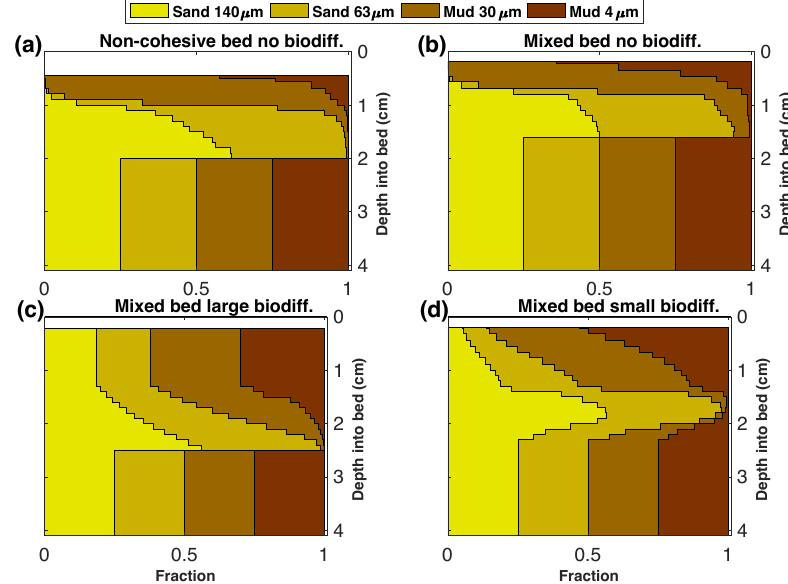
Figure 7. Comparison of final bed stratigraphy for resuspension and settling simulations showing the fraction of each sediment class dis- tributed in each bed layer. (a) Non-cohesive bed with no biodiffusion (same as Fig. 5d, included for comparison); (b) mixed bed with no biodiffusion; (c) mixed bed with large biodiffusion ( D s = 10 − 5 m 2 s − 1 ); and (d) mixed bed with small biodiffusion ( D s = 10 − 10 m 2 s − 1 ). The final sediment fraction distribution after two successive erosion–deposition events lasting 5 days (similar to Fig. 5b) is shown. The same four sediment classes were used in all experiments, but their cohesive behavior